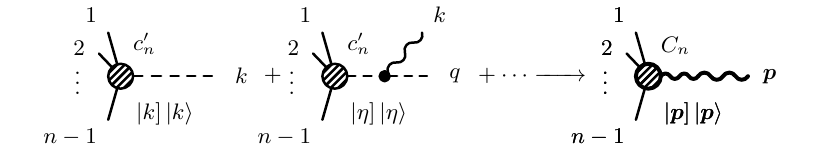
Figure 2 . High-energy origins of the leading and subleading, helicity-flipped, spinor components of massive fermions, transverse and longitudinal vectors. The ellipsis stands for amplitudes with additional Higgs